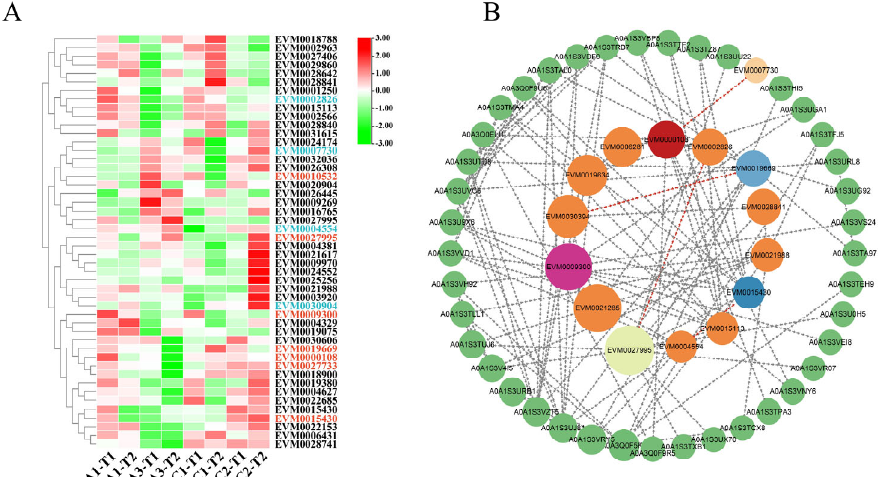
Figure 5. Heat map and protein interaction analysis of differentially expressed genes. ( A ) Expression profiles of WRKY, PHD, and MYB gene families. A1 and A3 represent the two salt − tolerant samples of mungbeans, C1 and C2 represent the two salt − intolerant samples of mungbean, and T1 and T2 represent the concentrations of 100 mM NaCl and 200 mM NaCl, respectively. The red gene numbers represent seven differentially expressed genes and the blue and black gene numbers represent the predicted interacting genes. Genes with FPKM > 0.5 were chosen in this study. ( B ) Circles represent the nodes of each gen, and the sizes of the circles represent the intensity of protein interactions, which is deduced by the value of the Btweenness parameter. The two lines between nodes indicate that two proteins may interact.